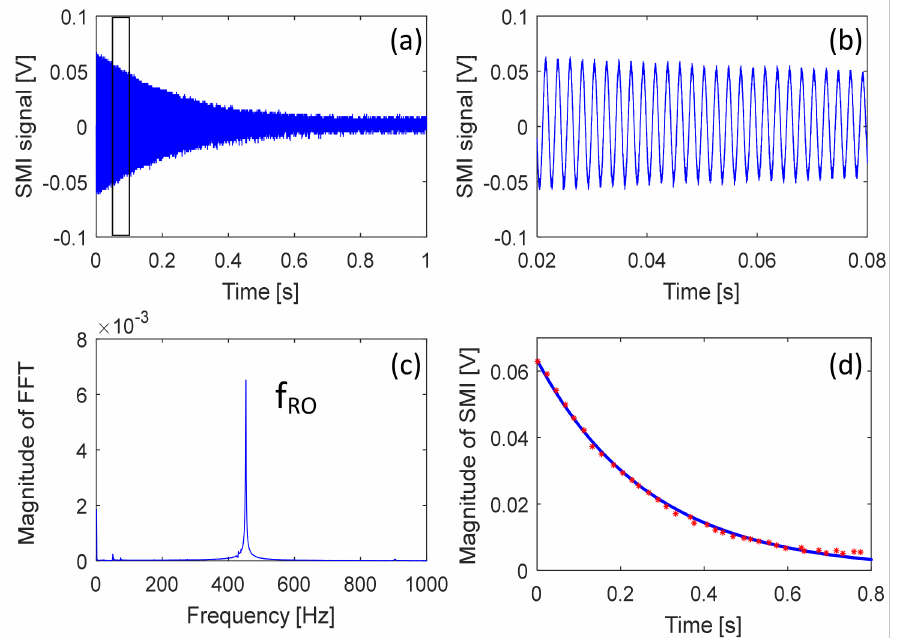
Figure 7. Example of the experiment results for brass specimen, ( a ) observed SMI signal, ( b ) zoomed- in SMI signals, ( c ) FFT magnitude spectrum, ( d ) curve fitting results.